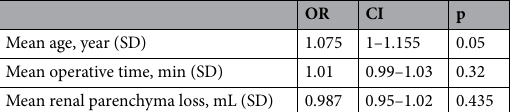
Table 4. Multivariable analysis of predictive factors of significant renal function